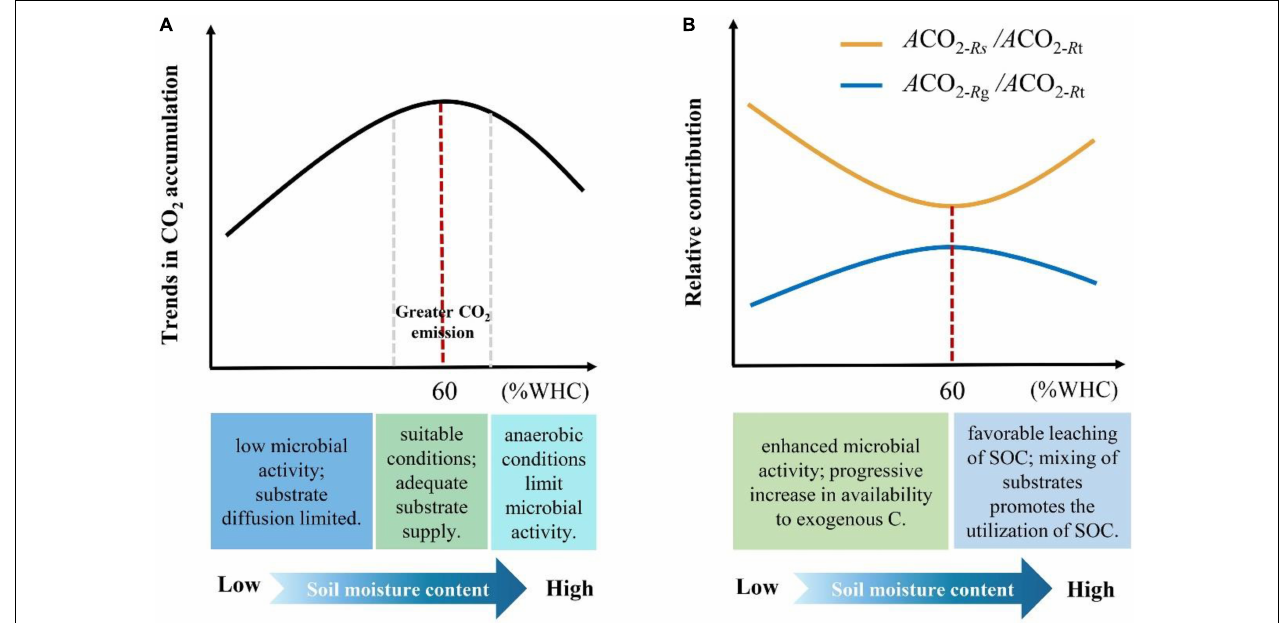
FIGURE 6 | Mechanisms of soil moisture content affecting microbial utilization of LOC and native SOM. (A) The black line indicates the trend of cumulative CO 2 emissions under different moisture content treatments, and the red-dash line indicates the maximum CO 2 emissions when the soil moisture content is 60% WHC. The range of the two gray-dash lines indicates the moisture content interval with larger CO 2 emissions. The three blocks below the X -axis indicate the causes of the difference in soil CO 2 emissions under different moisture conditions. (B) The yellow and blue lines indicate the trends in the relative contribution of microbial utilization of native SOC and LOC to total soil respiration under different moisture treatments, respectively. The red dashed line indicates that 60% WHC is the threshold that causes the change in the proportion of relative contribution. The two blocks below the X -axis indicate the causes of this